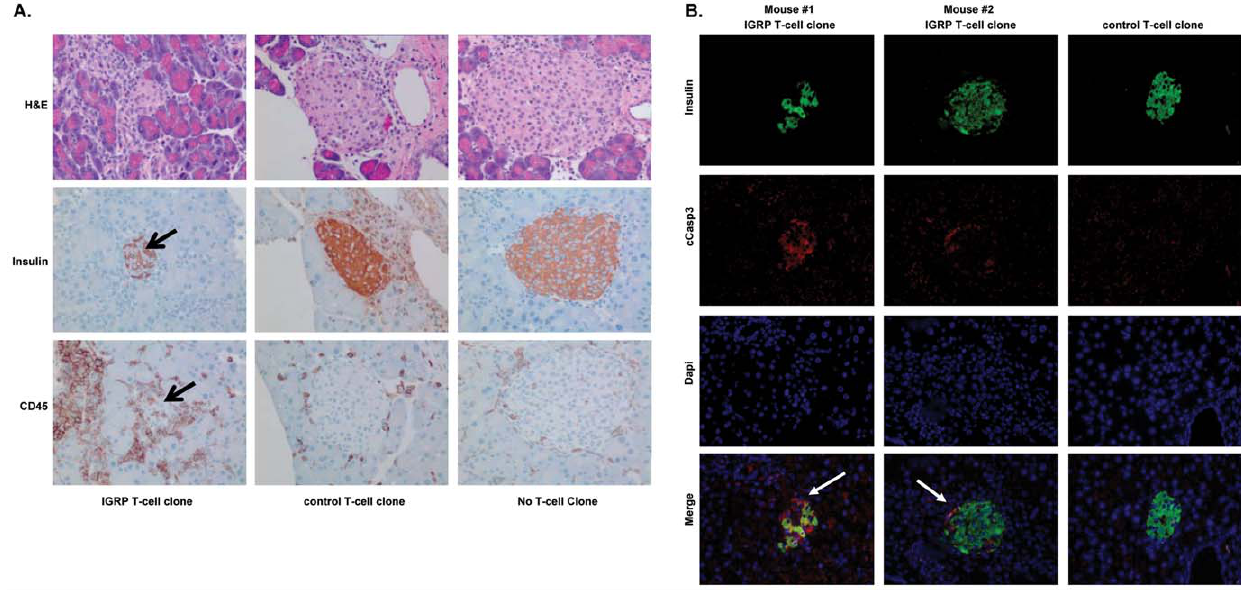
Figure 3. IGRP-specific T-cells are able to infiltrate and destroy beta-cells following intra-pancreatic injection into NOD- scidIL2r c null HHD mice. NOD- scid IL2r c null HHD recipient mice were injected i.v. with 20 6 10 6 PBMC from an HLA-A*0201 + healthy donor. Two days later, these mice were injected intra-pancreatically with either 5 6 10 6 IGRP-specific T-cells (left), 5 6 10 6 control T-cells (middle) or were sham injected (right). Four weeks later, the pancreata were isolated and histologically examined. A, Sections of recipients of IGRP-specific or control T-cells, or of those receiving a sham injection were stained with H&E (upper panel) to visualize the histological integrity of the islets or stained for insulin (middle panel) to identify the beta cells or human CD45 (lower panel) to visualize the human T-cells. Similar data were obtained when staining sections for human CD8. B, Pancreatic sections were stained for insulin, cCaspase-3 to detect apoptotic cells and DAPI to identify nuclei. Individual fluorescence as well as an overlay is presented. Shown are representative examples of 5 mice per